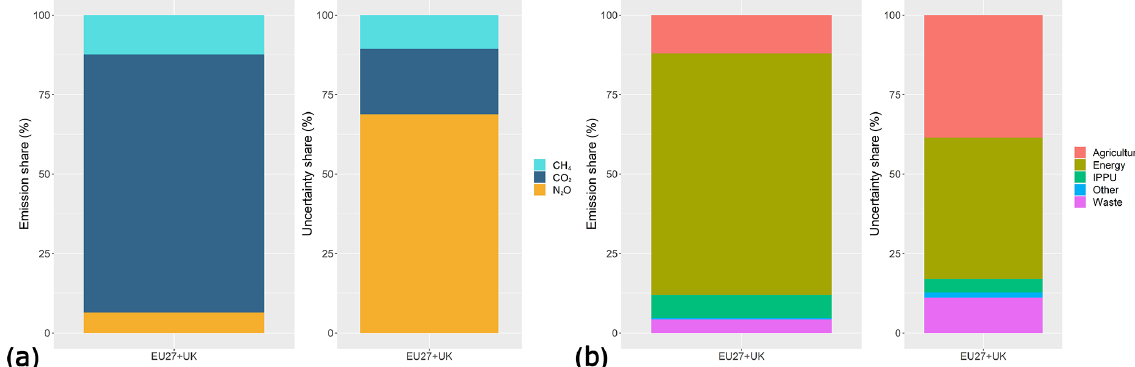
Figure 12. EU27 + UK share of emissions and uncertainty by (a) gas and (b) category. IPPU stands for industrial processes and product